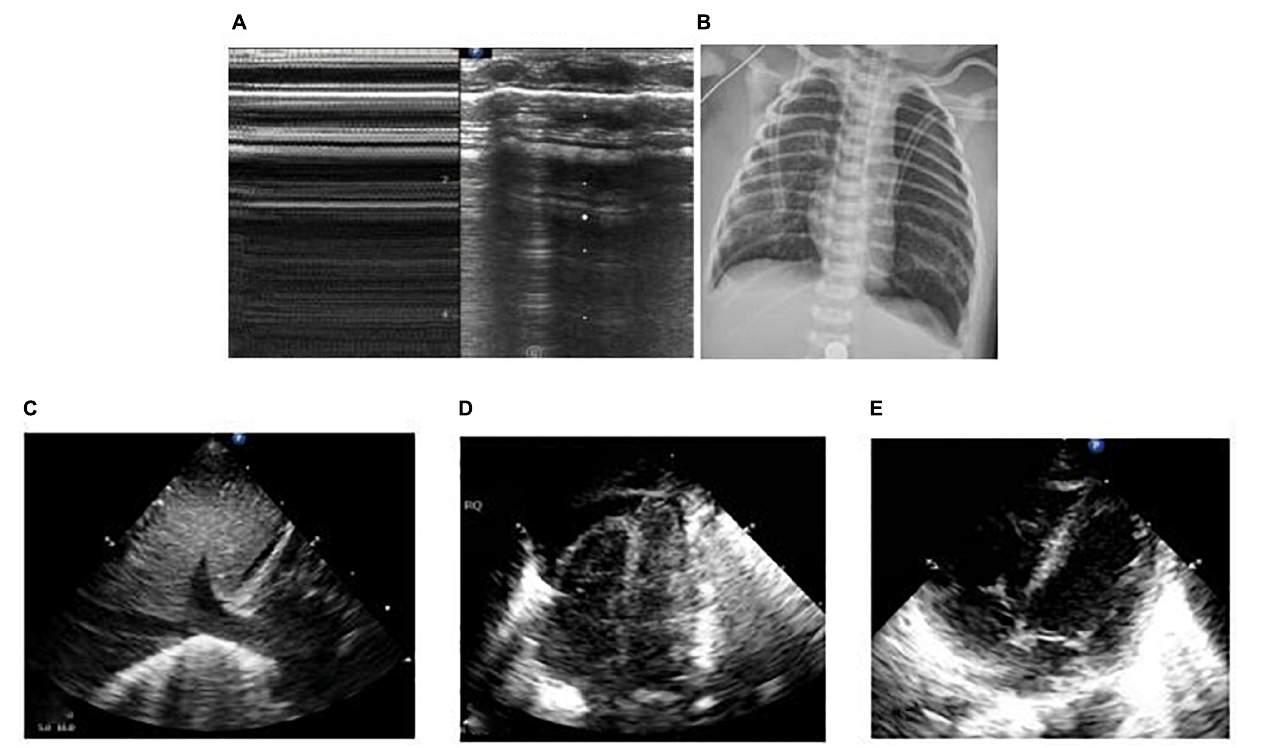
FIGURE 4 | The patient was born at 39 weeks of gestational age by natural delivery. The amniotic fluid was III turbid, and the Apgar score of 1, 5, and 10 min of birth were 2, 3, and 6 points. Respiratory distress occurred after birth and requiring mechanical ventilation. It was diagnosed as neonatal meconium aspiration syndrome. Under mechanical ventilation, man-machine incongruity appeared. The patient had weakened breath sounds in both lungs, a heart rate of 120 beats/min, dull heart sound, pale skin tone, cool limb ends, and weak radial artery beats. The blood pressure was 56/35 mmHg, and the shock score was 5 points. Continuous hypoxemia appeared, the arterial blood gas was PO 2 30.4 mmHg, and calculated Oxygenation index (OI) value was 50. Emergency bedside ultrasound revealed the lung slip of both lungs disappeared and without B-line, stratospheric sign showed, and the lung point was not explored, suggesting the diagnosis of massive pneumothorax on both sides (A) . Emergency thoracocentesis was performed under ultrasonic monitoring. After the operation, the blood oxygen saturation increased, blood pressure rose to 65/40 mmHg and the heart sound was strong. After 30 min, the X-ray operator at the bedside arrived, and the X-ray chest film showed bilateral pneumothorax (B) . In emergency situations, bedside ultrasound is easier to obtain than X-ray examination. In the figure, who has massive pneumothorax on both sides, hours after thoracic puncture and drainage, the baby appeared to cyanosis, the breath sounds in both lungs was weak, the heart rate increased to 180 beats/min. Reexamination of LUS showed that pneumothorax decreased and the lower boundary of lung was too low, bedside cardiac ultrasound showed inferior vena cava expansion and fixation (C) , ventricular filling and relaxation limitation (D) , suggesting that the patient had excessive lung expansion. The ventilator pressure was reduced to increase the returning blood volume, and the heart rate decreased gradually to 150 beats/min. Ventricular filling and diastolic improvement were observed by ultrasound (E)